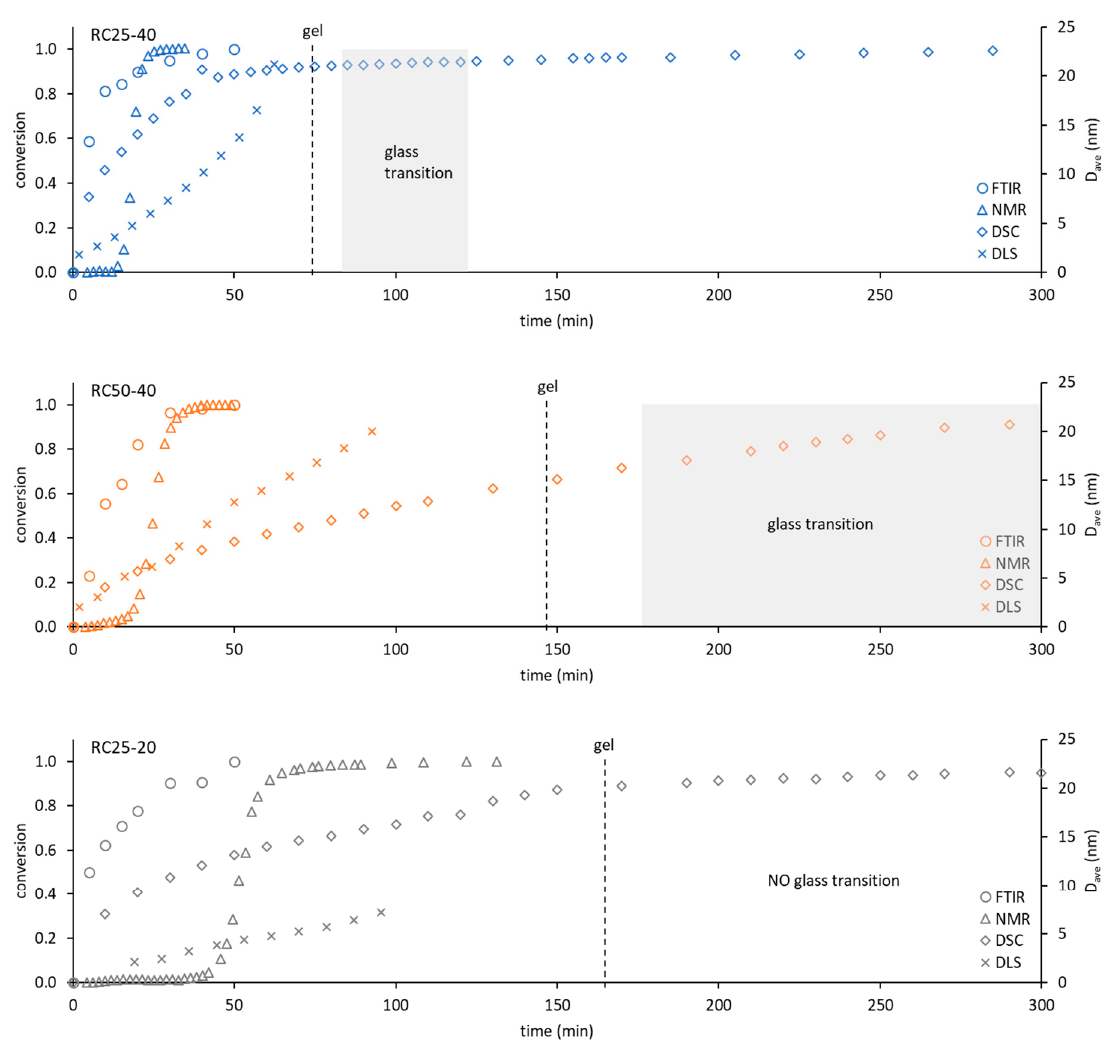
Figure 9. Comparison of the used techniques in terms of time dependence of conversion (FTIR, NMR, DSC—details of the calculation in the Section 5) or the particle diameter (DLS). The dashed line marked as ‘gel’ indicates the time of gelation (tilt test); the gray area corresponds to the time interval in which the glass transition could be detected by DSC.